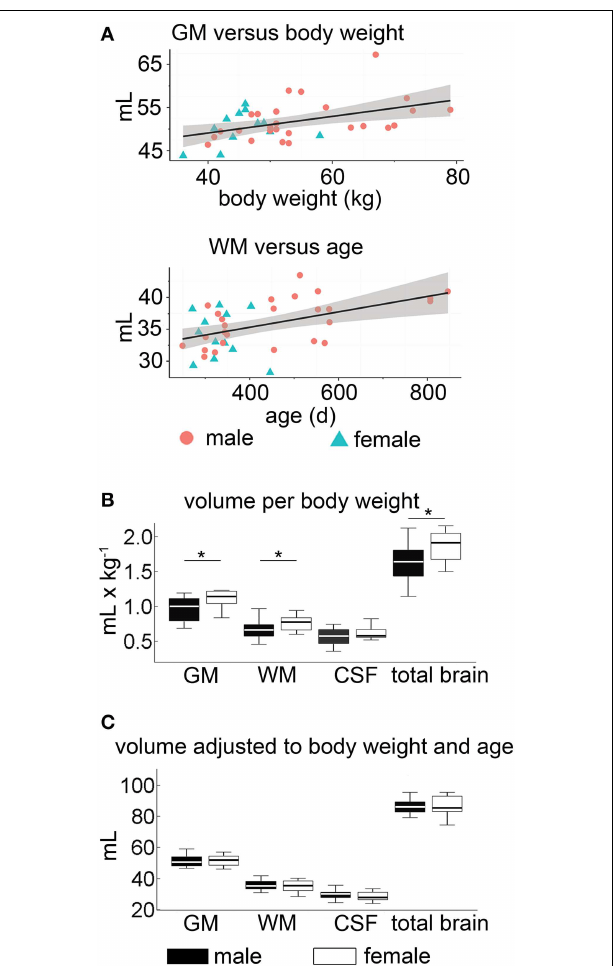
FIGURE 7 | Volumetric analyses within the proof-of-principle study. (A) The correlation of body weight on GM and age on white matter WM volumes, respectively, showed a slight positive correlation. (B) Sex differences: significant tissue volume differences of GM and WM were observable between male (black) and female (white) sheep when normalized to BW ( * p < 0 . 05 ). (C) When simultaneously accounting for the effect of body weight and age in a linear model, no statistical differences of the absolute adjusted brain tissue volume between the sexes were detectable ( p > 0 . 05 ). The box plots show 95% confidence interval, 25/75% quartile and median. GM, gray matter; WM, white matter; CSF,